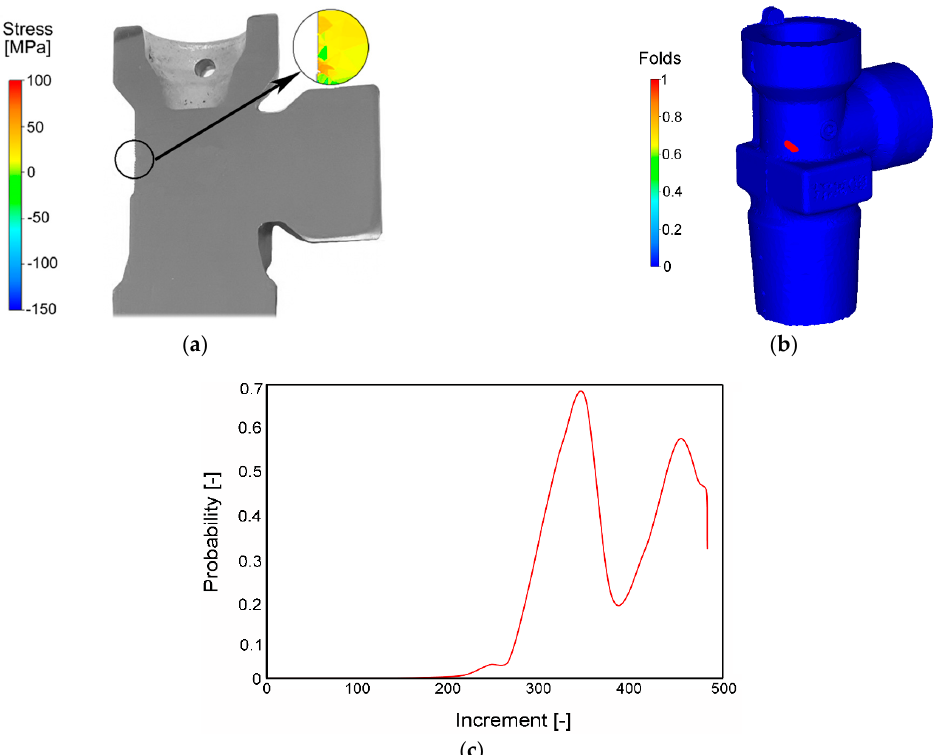
Figure 3. Stress distribution during hot forging in the location of the crack ( a ); predicted probability of the occurrence of folds in scale from 0 (0%) to 1 (100%) ( b ); Cockroft–Latham criterion during the die-forging processing step ( c ).